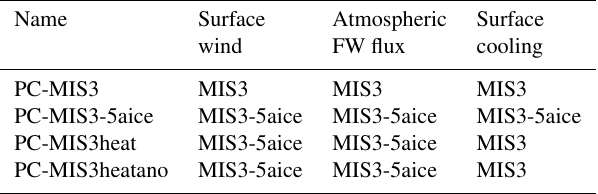
Table 2. Partially coupled experiments. In PC-MIS3heatano, cli- mate anomalies in surface wind and atmospheric freshwater (FW) flux between MIS3-5aice and MIS3 are added to MIS3.